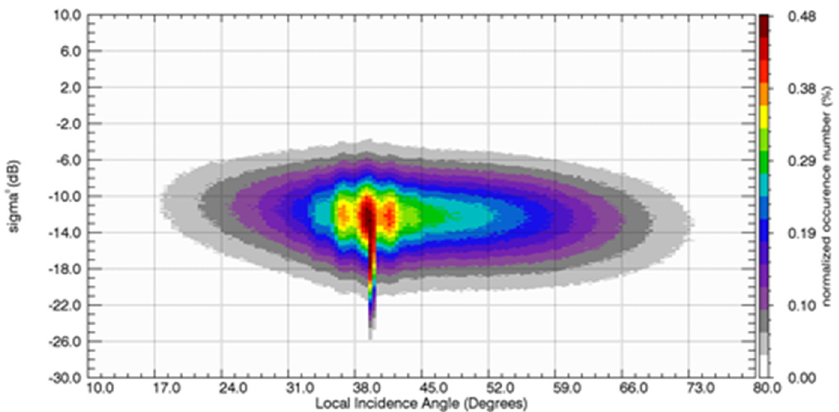
Figure 15. Backscattering coefficient σ 0 (dB) after the compensation of topography-induced distortions vs. local incidence angle (degree).